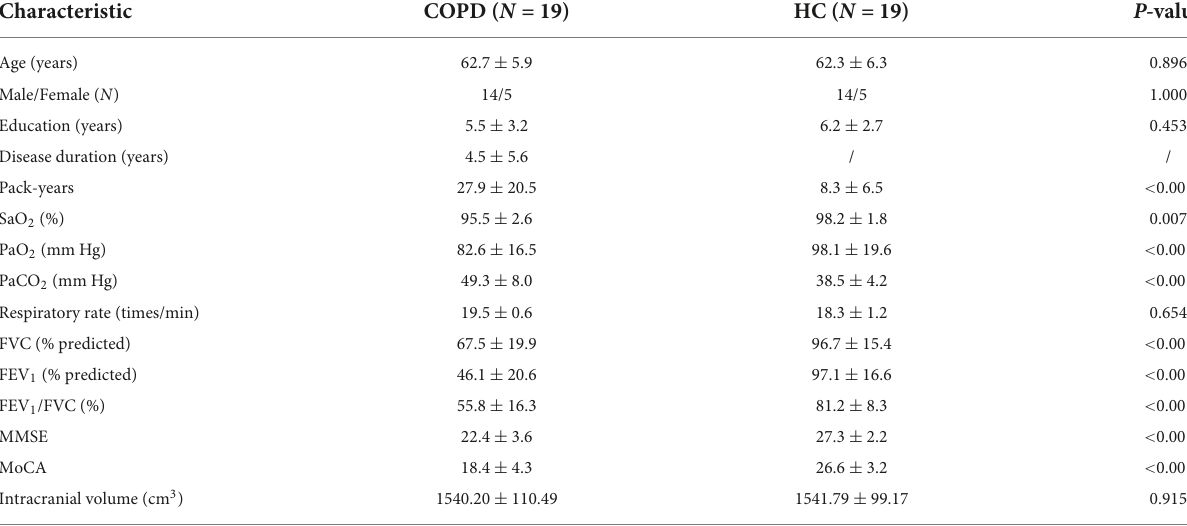
TABLE 2 Demographic and clinical characteristics of COPD and HC.